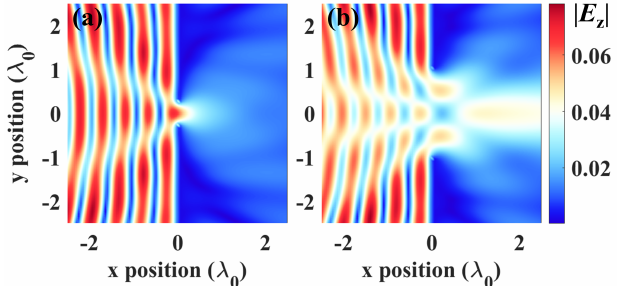
Figure 3. EDOF limit in key-hole scenario: ( a ) Diagram of the key-hole scenario. L = 5 λ 0 is the length of the source/receiving line, and D = 5 λ 0 is the distance between the source and receiving lines. A metallic sheet, with a S λ 0 hole in the center, is placed in the middle between the source and receiving lines; ( b ) EDOF limit versus S .